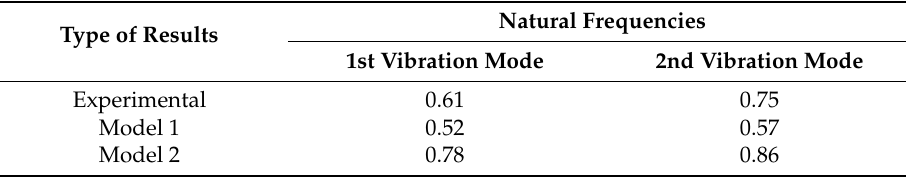
Table 5. Modal analysis results: model with undamaged infill masonry walls.